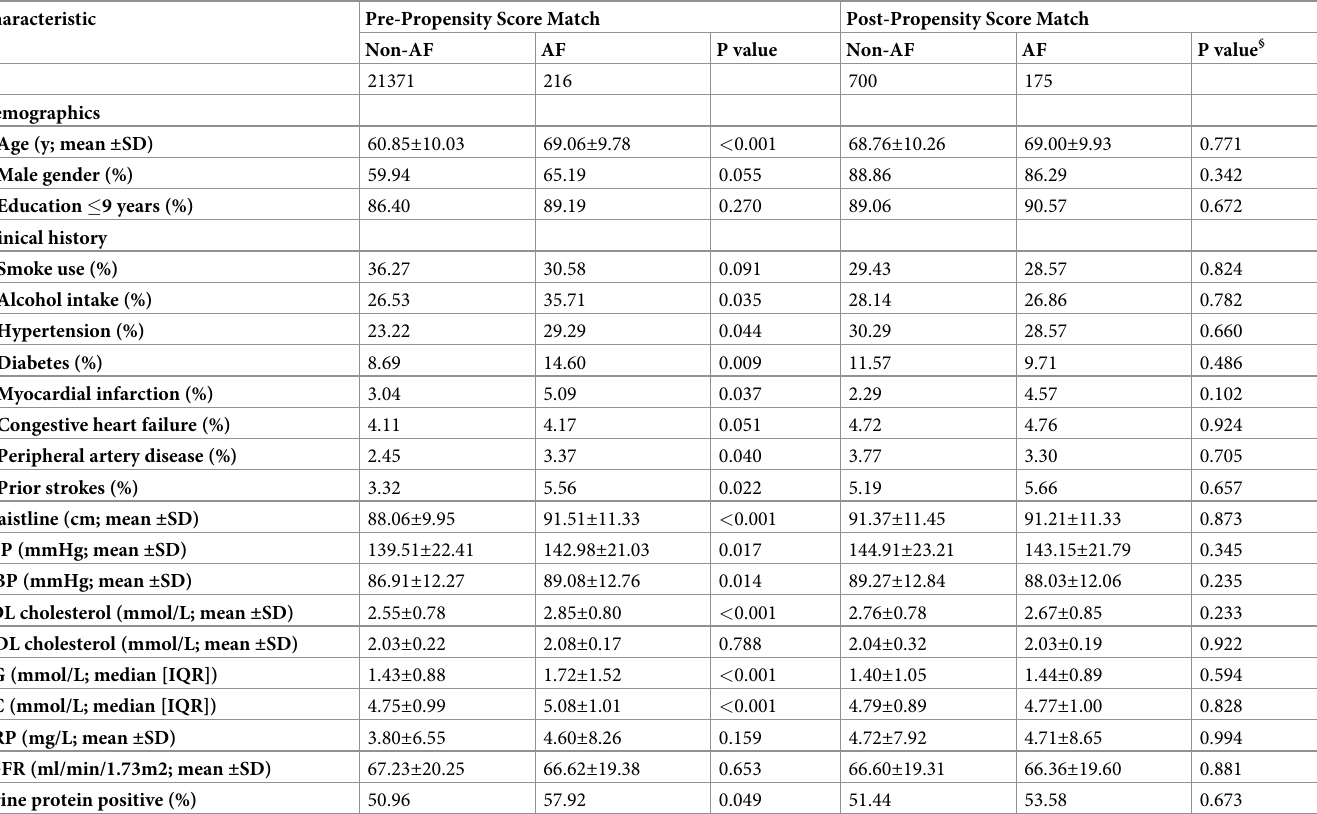
Table 1. Baseline characteristics according to the presence of AF before and after propensity score matching.